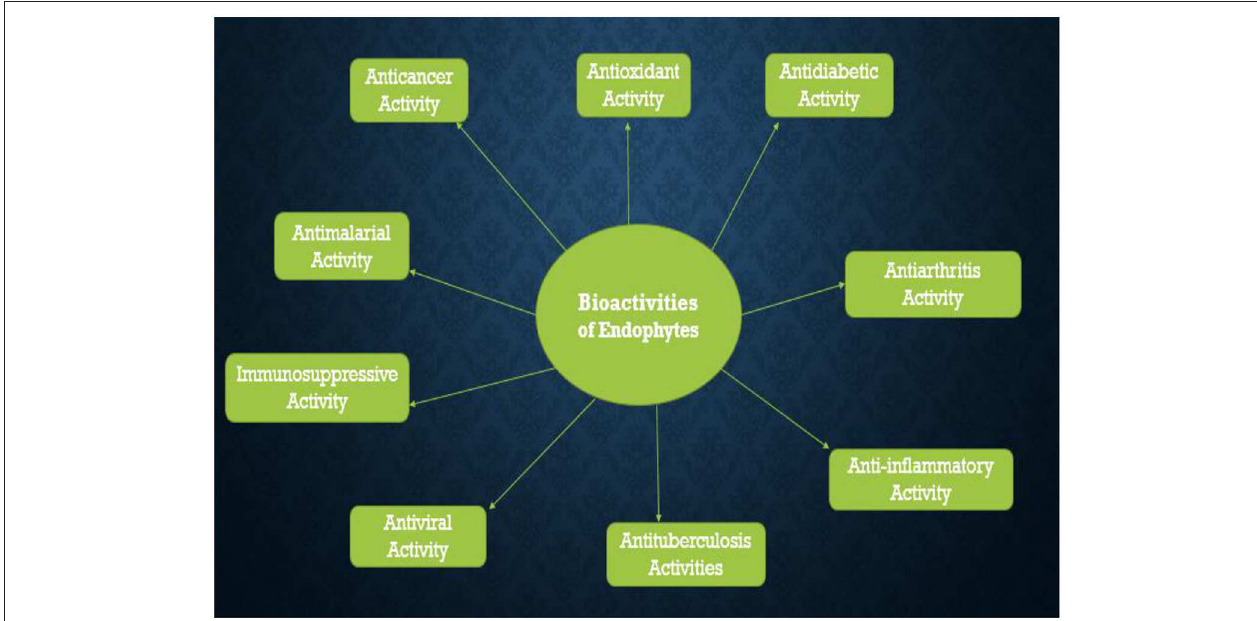
FIGURE 3 | Biological activities of importance to humans present in endophyte’s